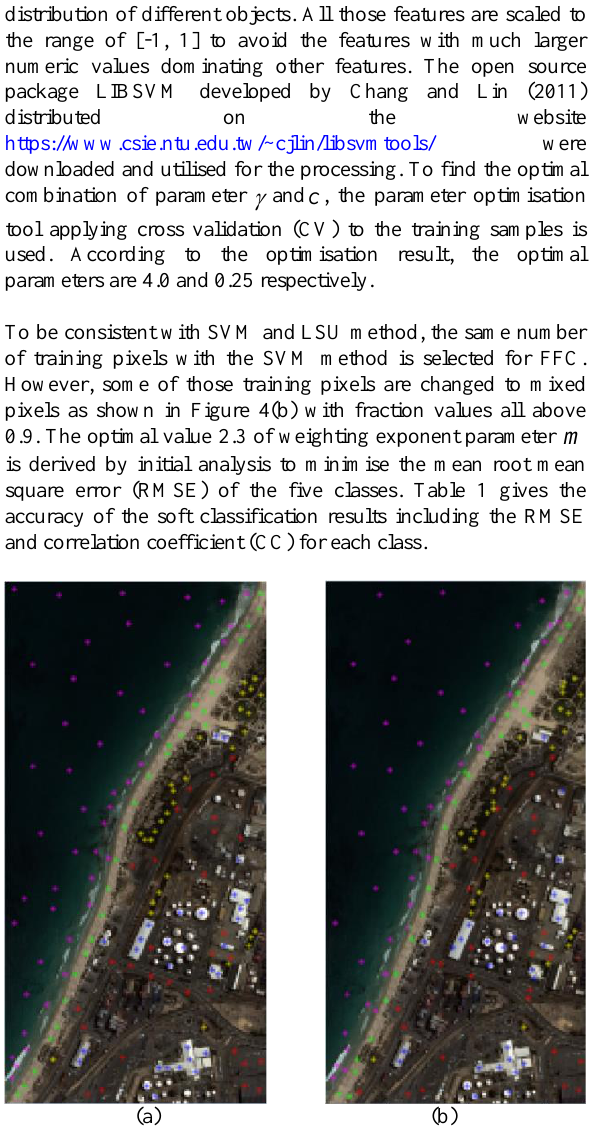
Figure 2. Framework of ANN WT (adapted from Mertens et al. (2004))